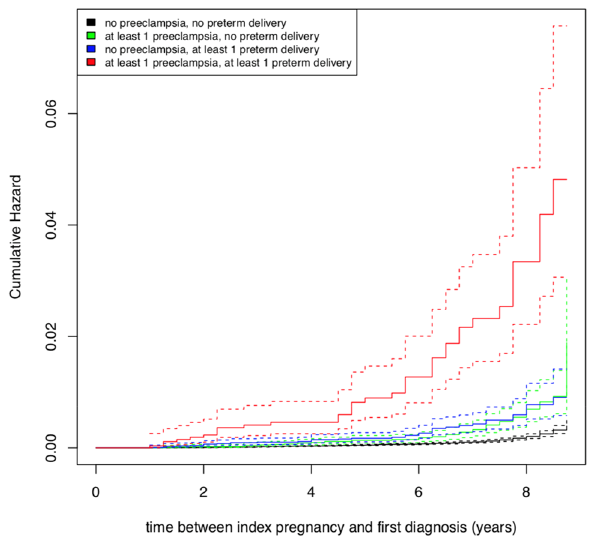
Figure 3. Cumulative hazard plot on risk of severe subsequent